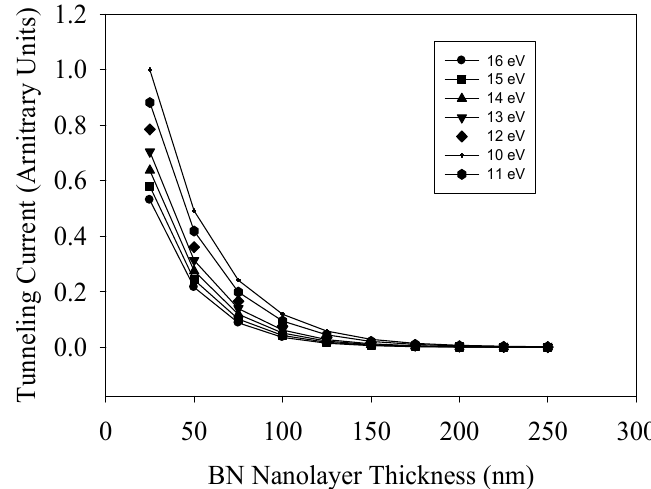
Figure 5. Dependence of relative tunneling current on the BNNS layer thickness with di ff erent e ff ective potential